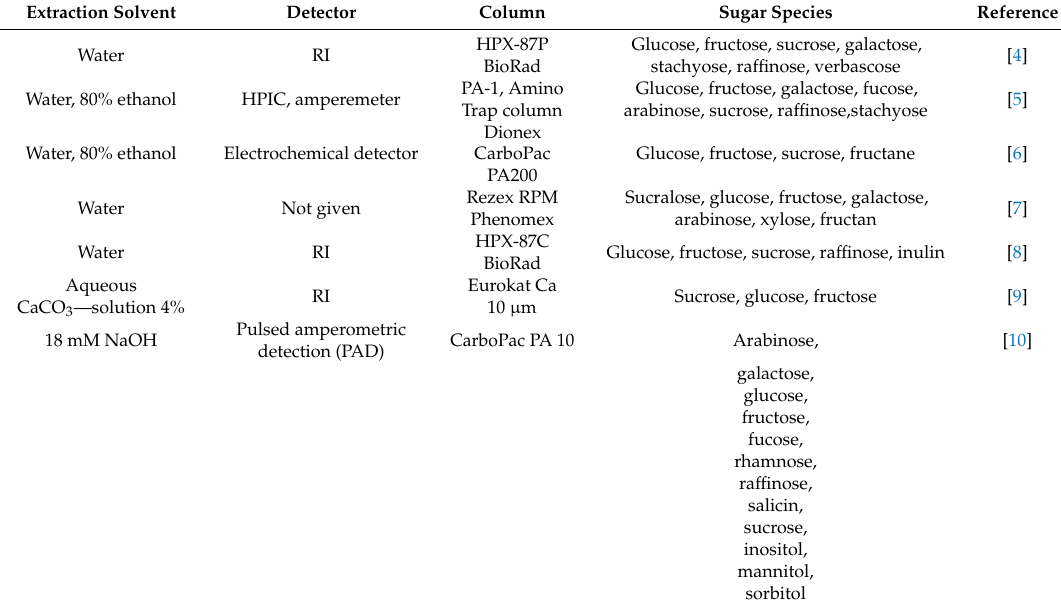
Table 1. Methods to determine individual sugars in